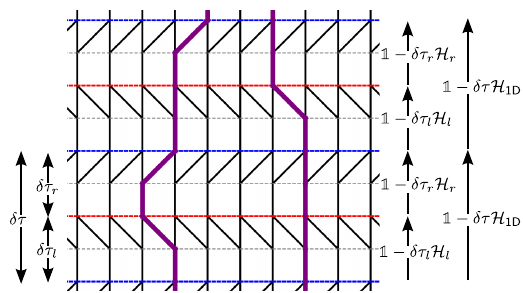
Figure 36: A redrawing of the honeycomb / brick lattice that clarifies the mapping between the nearest-neighbour TLIAF in the constrained manifold and H 1D [ Eq. 125 ] . H 1D translates the strings / fermions (purple lines) by four bonds, from dashed blue line to dashed blue line (the four possible paths are shown). Knowing the string / fermion configuration only on the blue dashed lines does not completely specify the Ising configuration, since the string can take two possible routes that result in no change in its x position. As a result, it is necessary to introduce into the coherent-state path integral extra states that take into account the string / fermion configuration on the red dashed lines (see Eq. 140). In order to do this the Hamiltonian is split into H left and right [ Eq. 138 ]